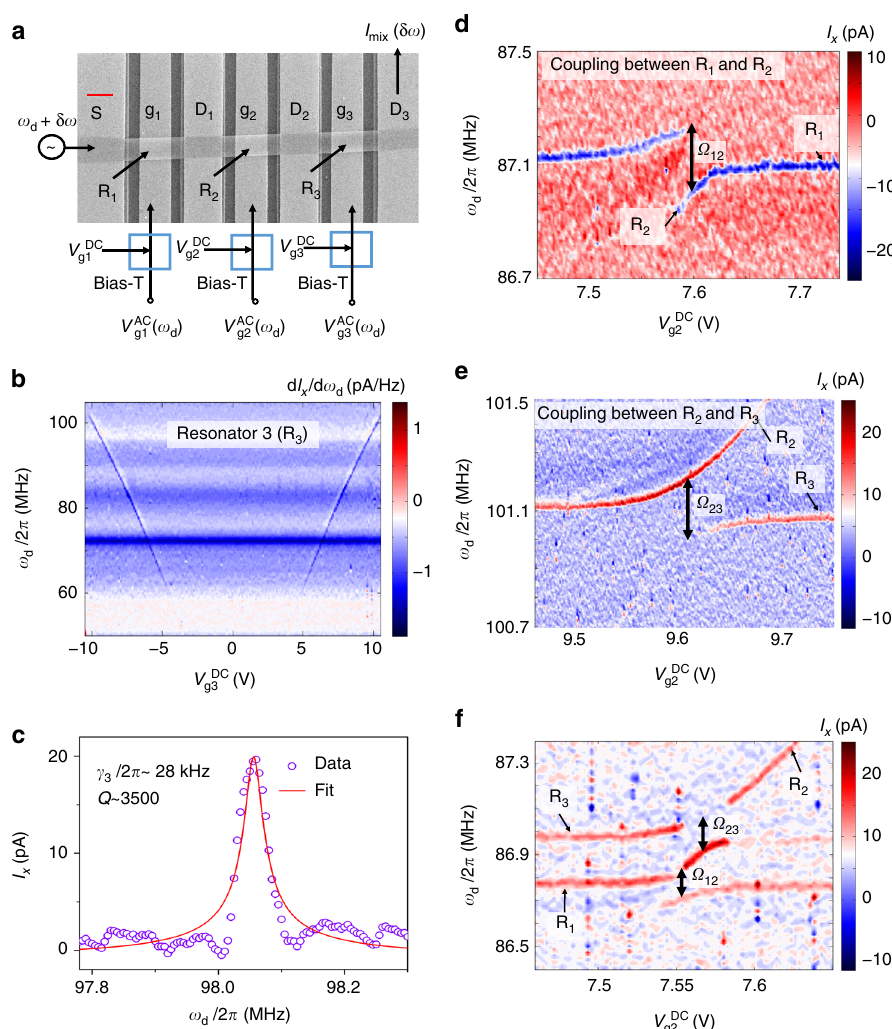
Fig. 1 Sample structure and device characterization. a Scanning electron microscope photograph of a typical sample. An ~1- μ m-wide graphene ribbon was suspended over four contacts, labeled as S, D 1 , D 2 , and D 3 , respectively. These contacts divide the ribbon into three sections, each with a gate of ~150 nm beneath the ribbon. A driving microwave with frequency ω d + δω is applied to contact S and is detected at contact D 3 after mixing with another driving tone with frequency ω d applied to one or more of the control gates. Scale bar is 1 μ m. b The differentiation of the mixed current d I x /d ω d as a function of